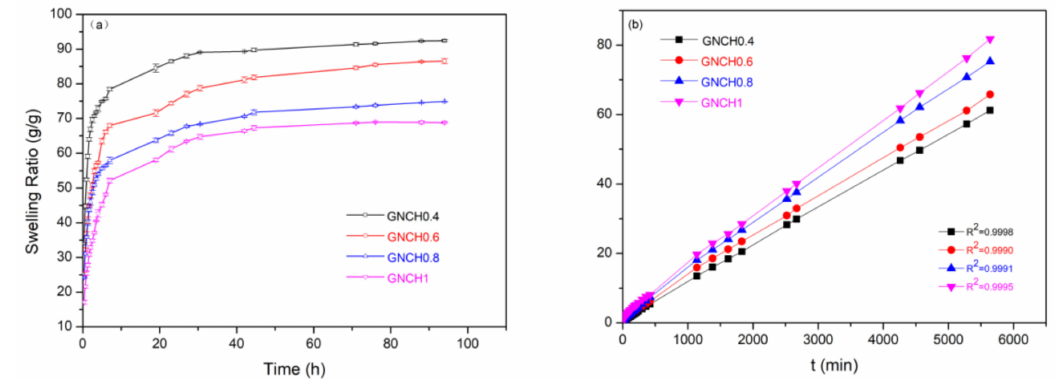
Figure 5. ( a ) Swelling rate and ( b ) pseudo-second-order kinetics of hydrogels in deionized water. All the values of correlation coe ffi cient (R 2 ) ≥ 0.999.